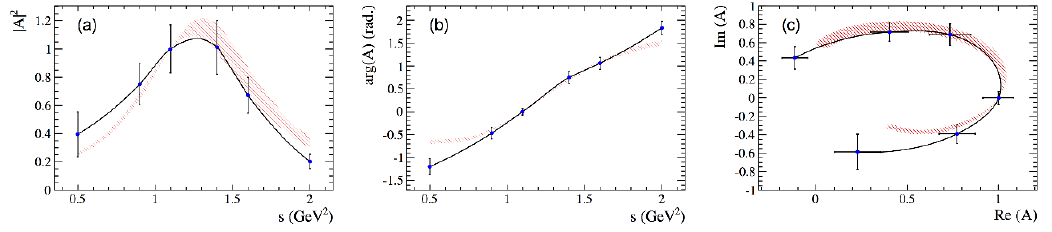
Figure 9 . Magnitude-squared (a), phase (b) and Argand diagram (c) of the quasi-model- independent a 1 (1260) lineshape. The (cid:12)tted knots are displayed as points with error bars and the black line shows the interpolated spline. The Breit-Wigner lineshape with the mass and width from the nominal (cid:12)t is superimposed (red area). The latter is chosen to agree with the interpolated spline at the point < ( A ) = 1, = ( A ) = 0.